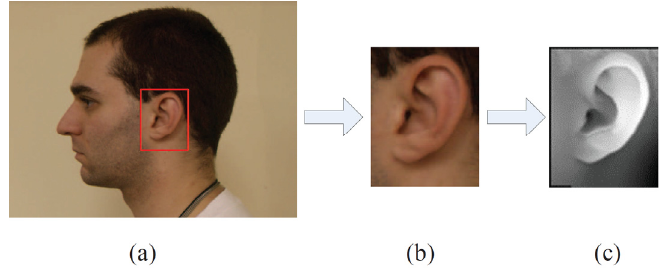
Figure 2. Ear detection and coarse segmentation: ( a ) Ear region detected; ( b ) Coarsely segmented ear; ( c ) Corresponding 3D ear data.